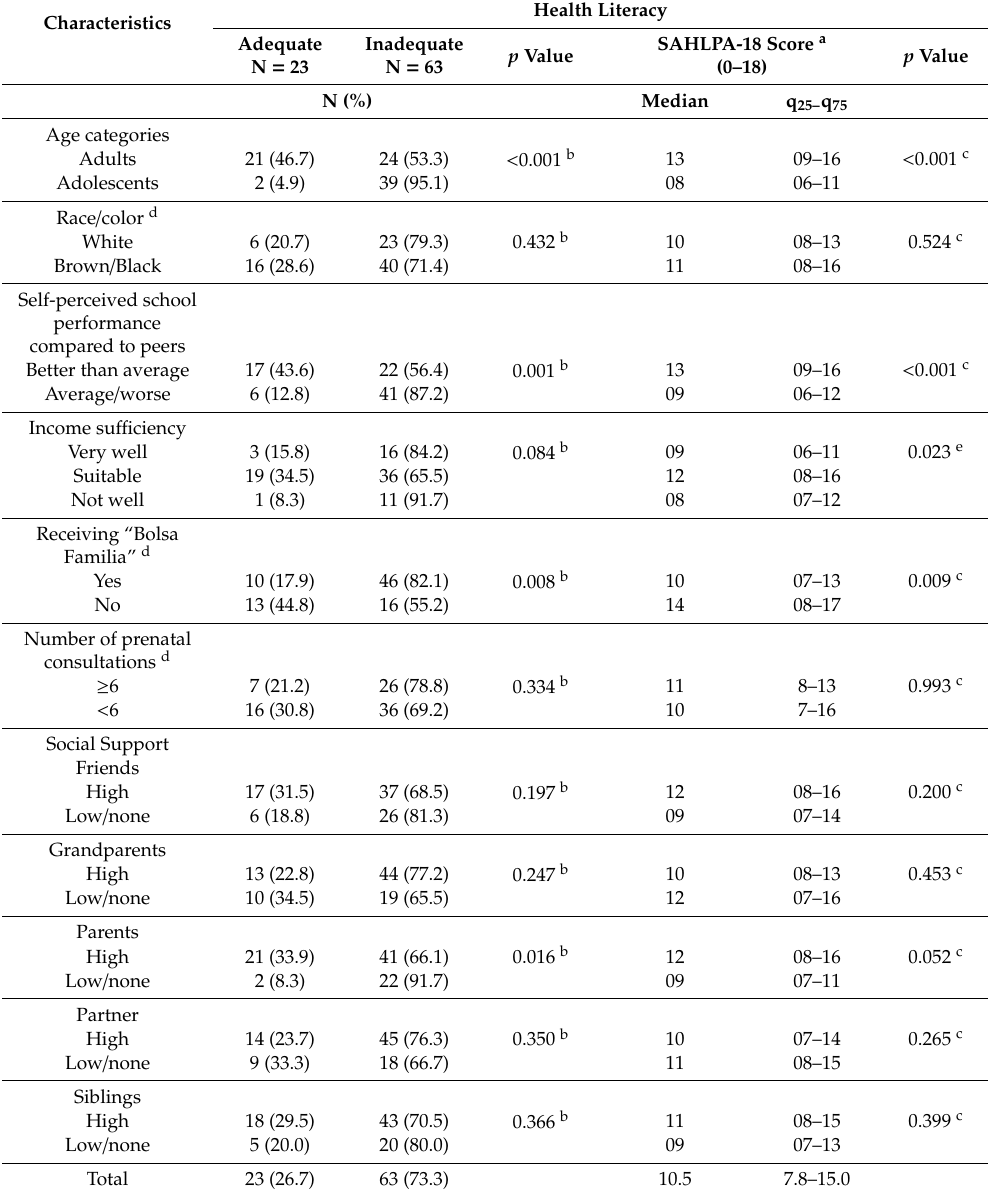
Table 2. Associations among health literacy and independent variables (N =